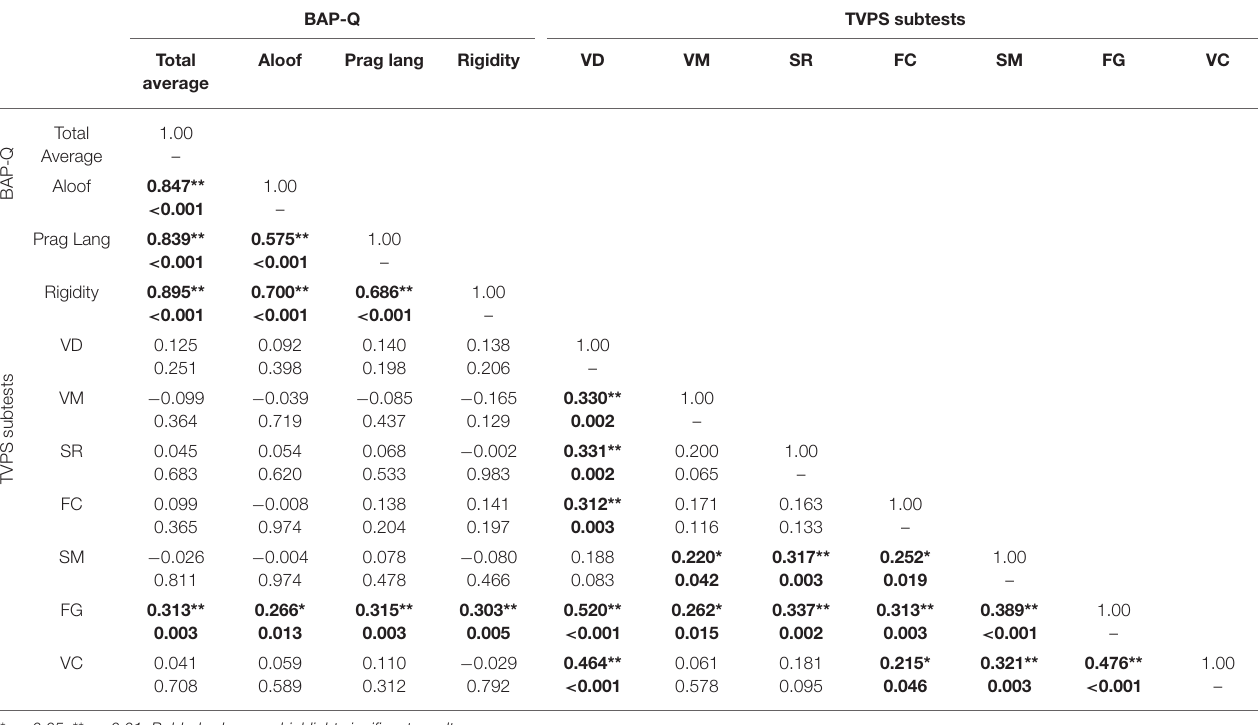
TABLE 5 | TVPS RDI scores across each of the seven TVPS subtests.